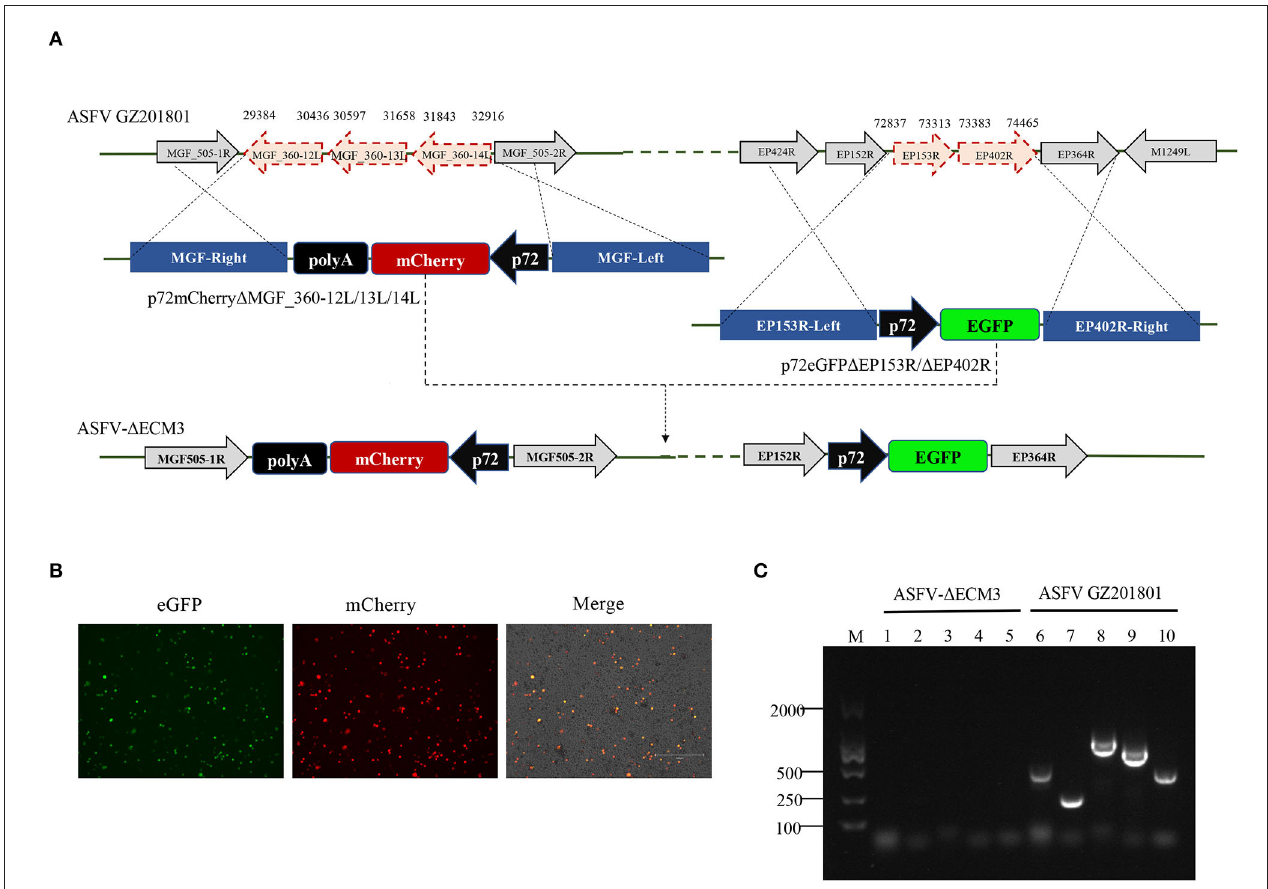
FIGURE 1 | Schematic of the construction of ASFV- 1 ECM3 deletion mutant. (A) The EP153R, EP402R, MGF_360-12L, MGF _ 360-13L, and MGF _ 360-14L genes from the GZ201801 genome were replaced by the p72eGFP 1 EP153R/ 1 EP402R and p72mCherry 1 MGF_360-12L/13L/14L recombination transfer vectors by homologous recombination. (B) eGFP and mCherry reporter fluorescence indicate BMDM cells infection with the ASFV- 1 ECM3 virus. (C) Confirmation of the ASFV- 1 ECM3 deletion mutant by PCR. Lanes 1 and 6 test for the EP153R gene. Lanes 2 and 7 test for the EP402R gene. Lanes 3 and 8 test for the MGF_360-12L gene. Lanes 4 and 9 test for the MGF _ 360-13L gene. Lanes 5 and 10 test for the MGF _ 360-14L